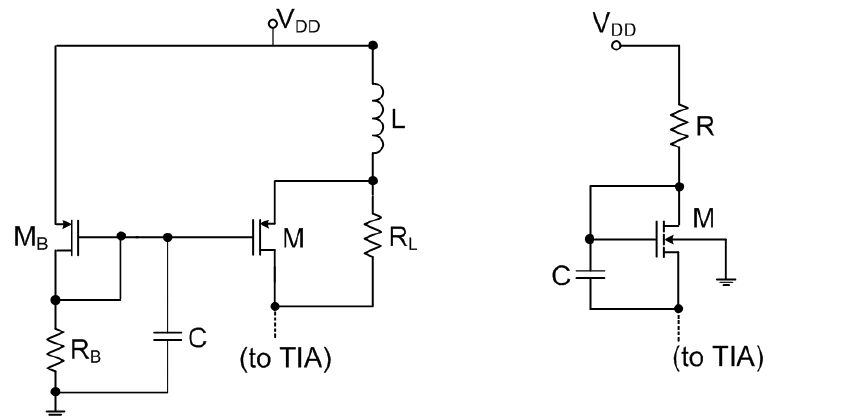
Figure 14. The bandwidth extension with inductive degeneration (left) and an active inductor approach